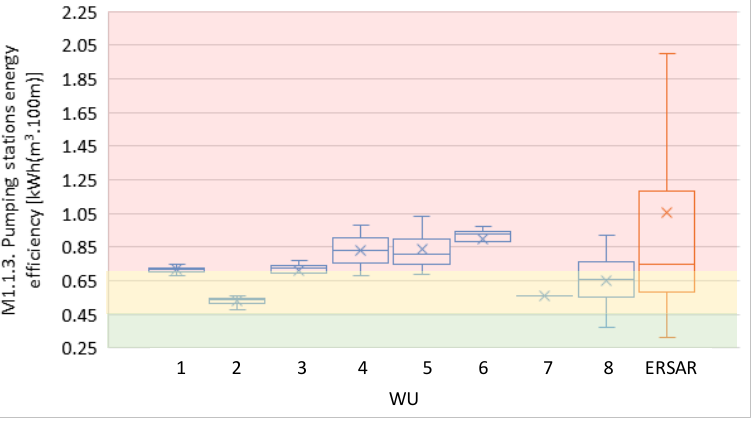
Figure 4. Results for the metric M1.1.3: pumping stations energy efficiency.